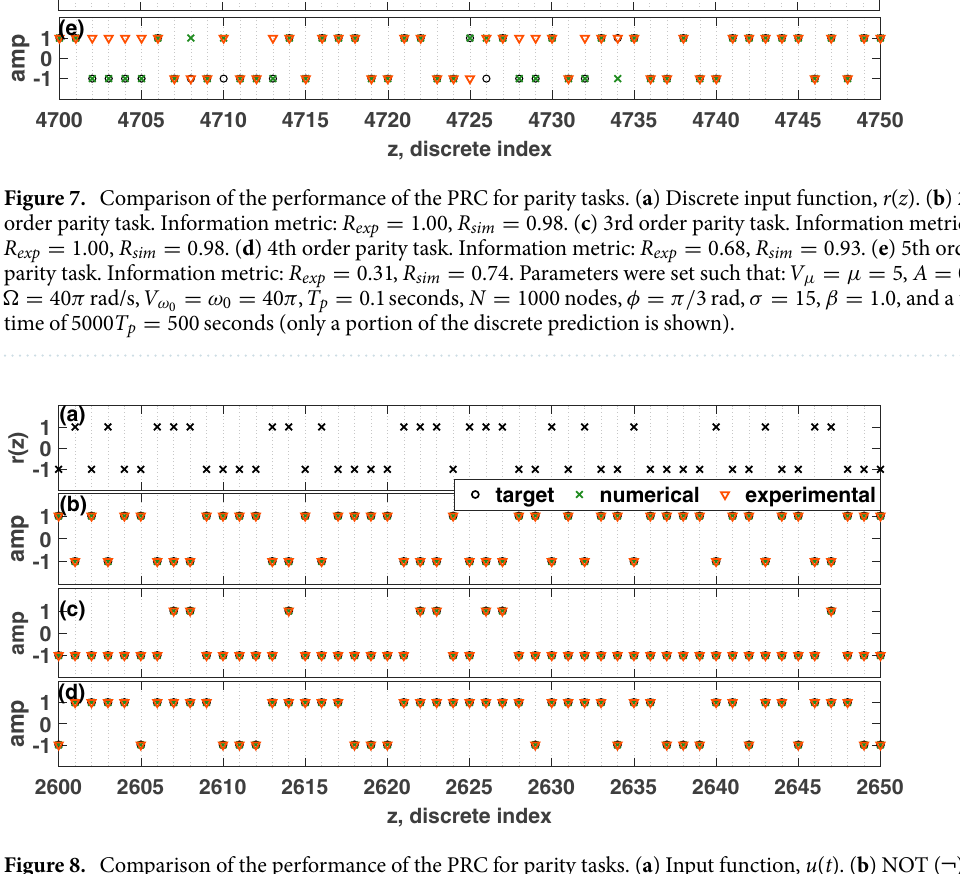
Figure 8. Comparison of the performance of the PRC for parity tasks. ( a ) Input function, u ( t ). ( b ) NOT ( ¬ ) gate. ( c ) AND ( ∧ ) gate, ( d ) OR ( ∨ ) gate. For all numerical and experimental results, the information rate was at the theoretical maximum; the Hopf PRC can act as any of the fundamental logic gates. Parameters were set such that: V µ = µ = 5 , A = 0.5 , � = 40 π rad/s, V ω 0 = ω 0 = 40 π rad/s, T p = 0.1 seconds, N = 1000 nodes, φ = π/ 3 rad, σ = 15 , β = 1.0 , and a total time of 3000 T p = 300 seconds. Only a portion of the response is shown